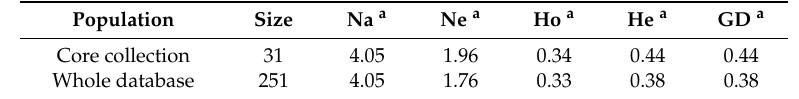
Table 5. Comparisons on genetic diversity indices between the core collection and the whole Dalbergia odorifera database.